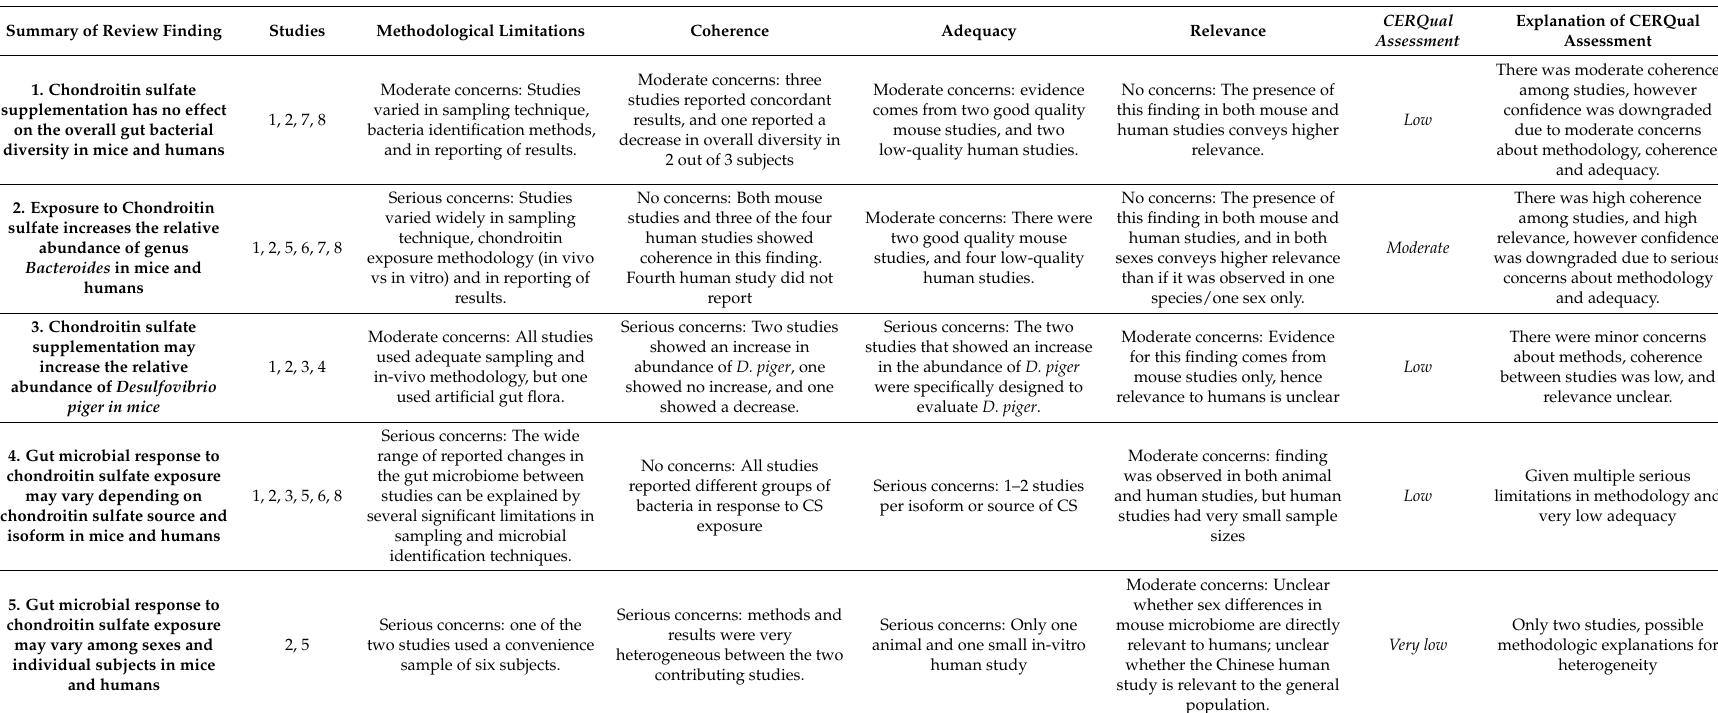
Table 3. CERQual Assessment of Confidence in the